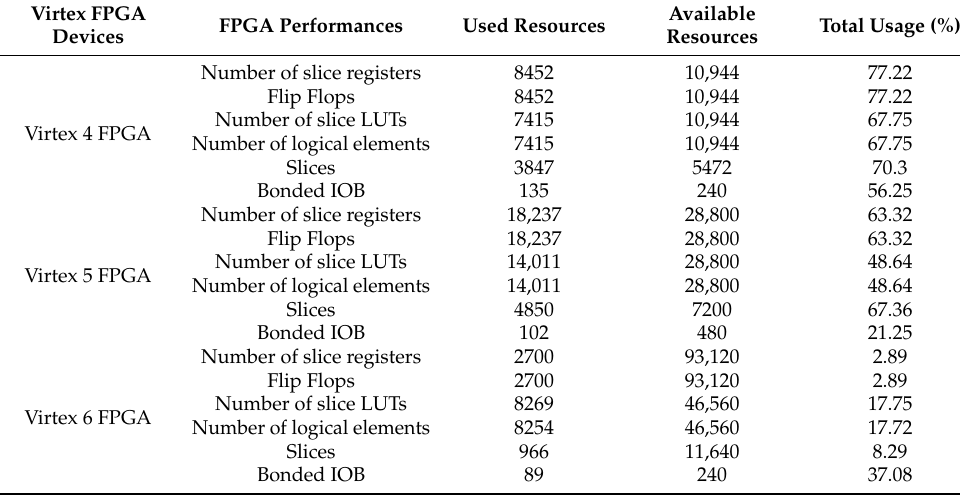
Table 3. Analysis of used resources for AES-FJMKE designed in Virtex devices.